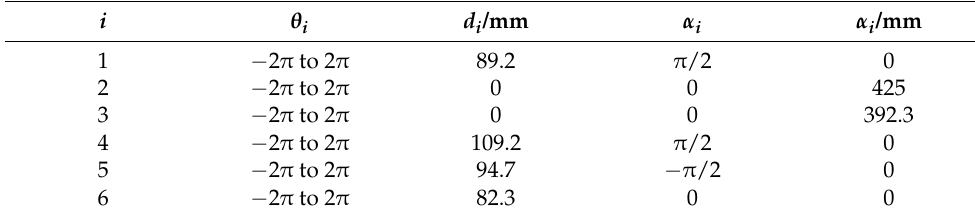
Table 1. The D-H parameters of the UR5